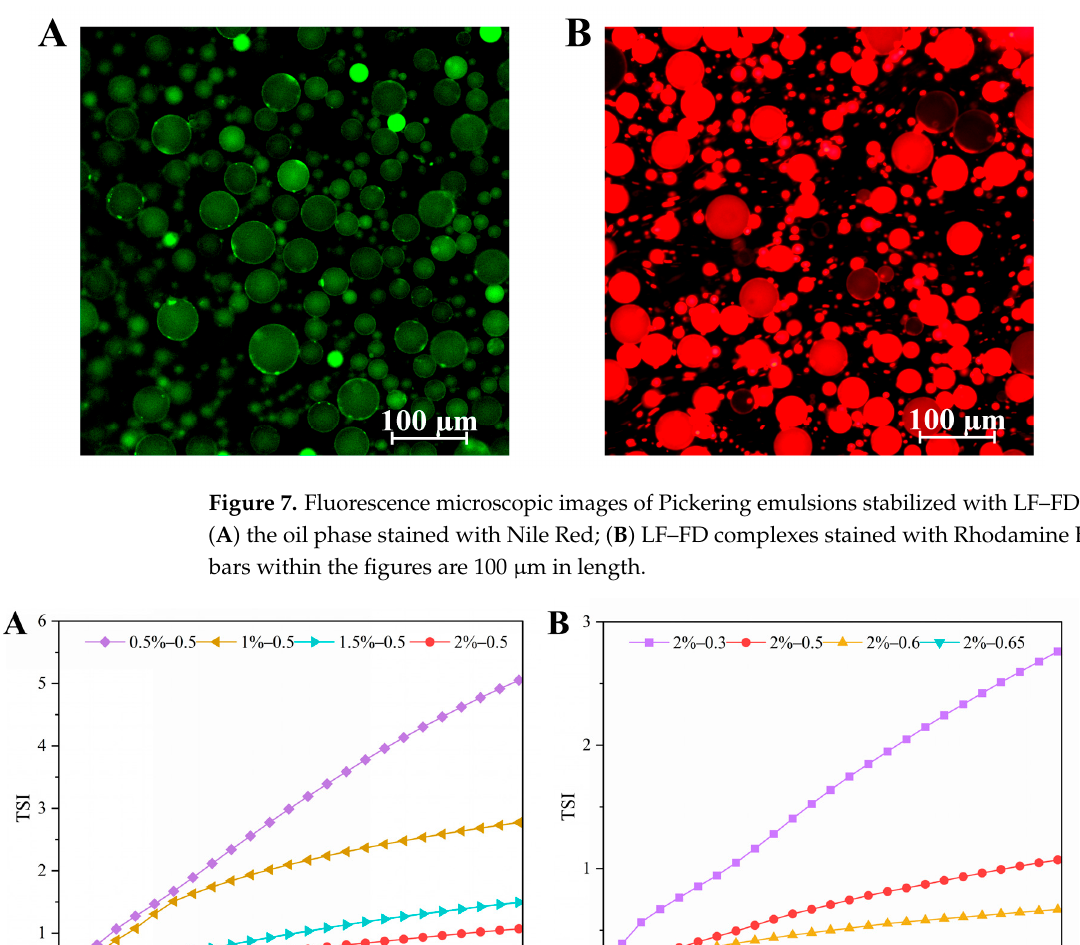
Figure 7. Fluorescence microscopic images of Pickering emulsions stabilized with LF–FD complexes: ( A ) the oil phase stained with Nile Red; ( B ) LF–FD complexes stained with Rhodamine B. The scale bars within the figures are 100 μ m in length.